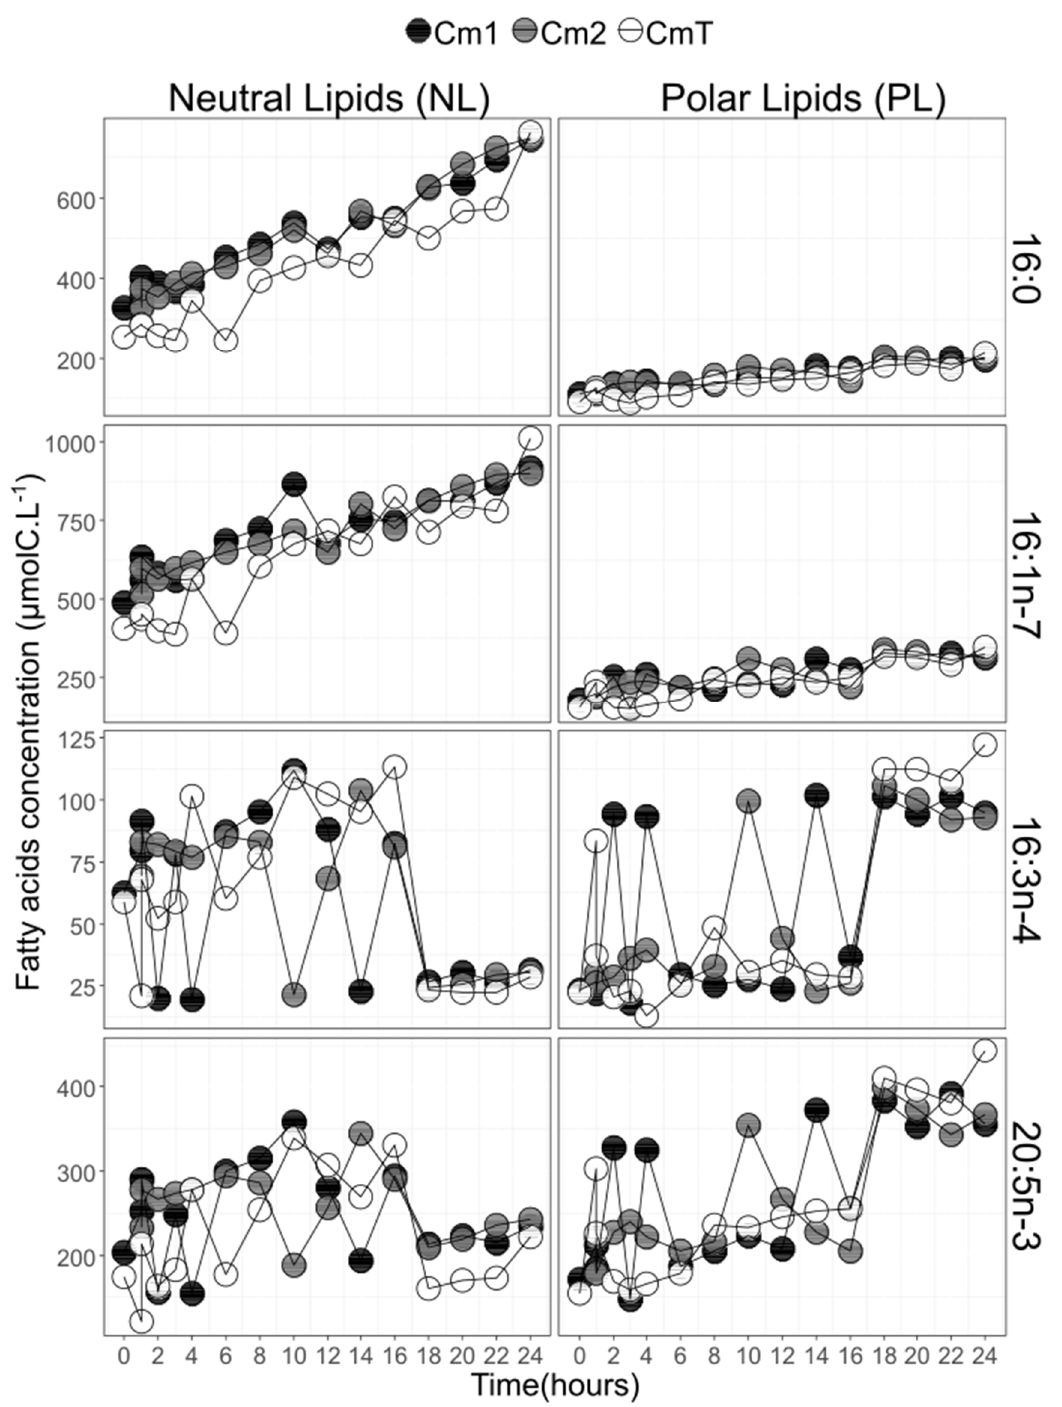
Figure 8. FA concentration dynamics in neutral lipid fraction (NL—left) and polar lipid fraction (PL—right) with time for the two most abundant C 16 fatty acids (16:0 and 16:1n-7), and the two end-product fatty acids (16:3n-4 and 20:5n-3) for the three culture balloons. Cm1 and Cm2 are the enriched balloons, and CmT is the control balloon (Cm = Chaetoceros muelleri ) .